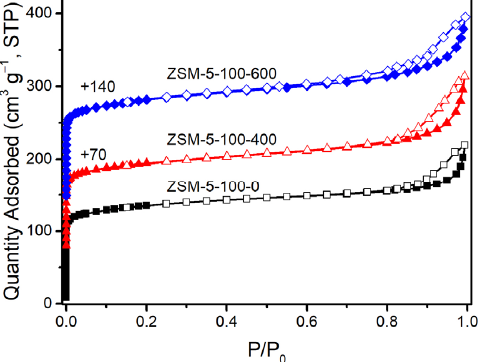
Figure 3. N 2 physisorption isotherms of ZSM-5 with Si/Al ratio of 100 synthesized with different amounts of toluene.